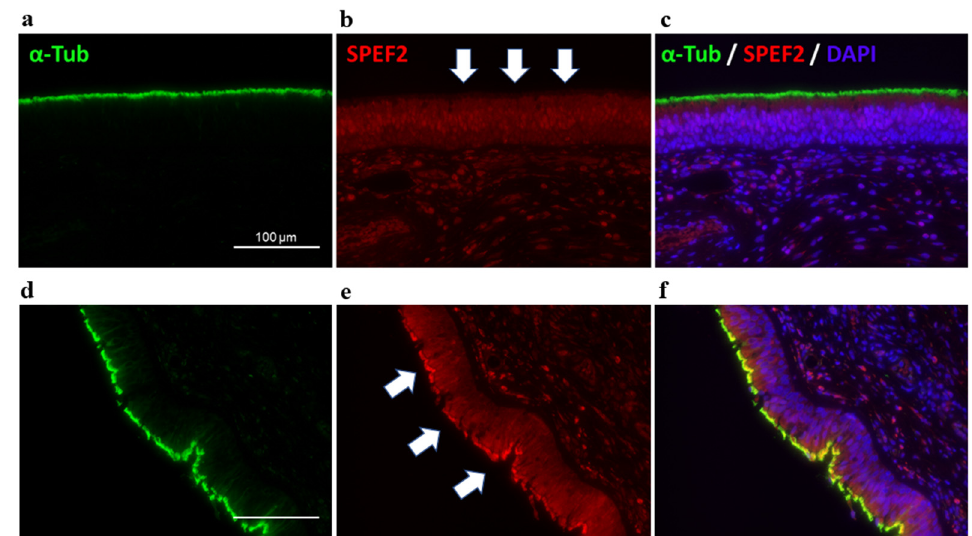
Figure 7. Immunofluorescence analysis. ( a – c ) Images of sinus tissues obtained by surgery for chronic sinusitis of the present case; ( d – f ) the other case of PCD used as a positive control. Anti-SPEF2 (HPA039606, Atlas antibodies, Bromma, Sweden) (red) is stained with anti-acetylated tubulin (T7451, Sigma-Aldrich, St Louis, MO, USA) (green) to visualize the entire ciliary axonemes, and with 4 ′ ,6-diamidino-2-phenylindole (17507, AAT Bioquest, Pleasanton, MO, USA) (blue) to show the nucleus as well. The white arrows and yellow color, indicate the presence of SPEF2 in the cilia in the image of the control ( e , f ). In ( b , c ), a lack of SPEF2 expression can be confirmed. Scale bar: 100 µ m.